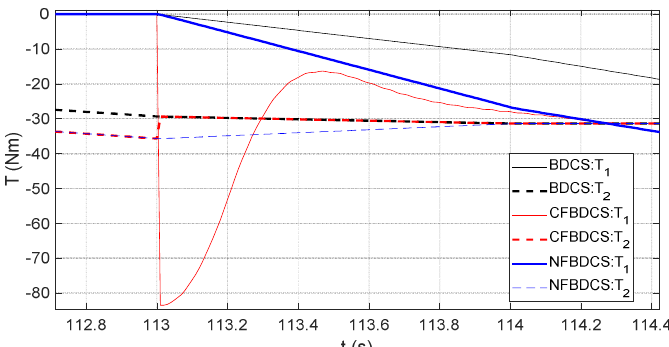
Figure 17. Torque profile from Mode 2 to Mode 1 & 2.